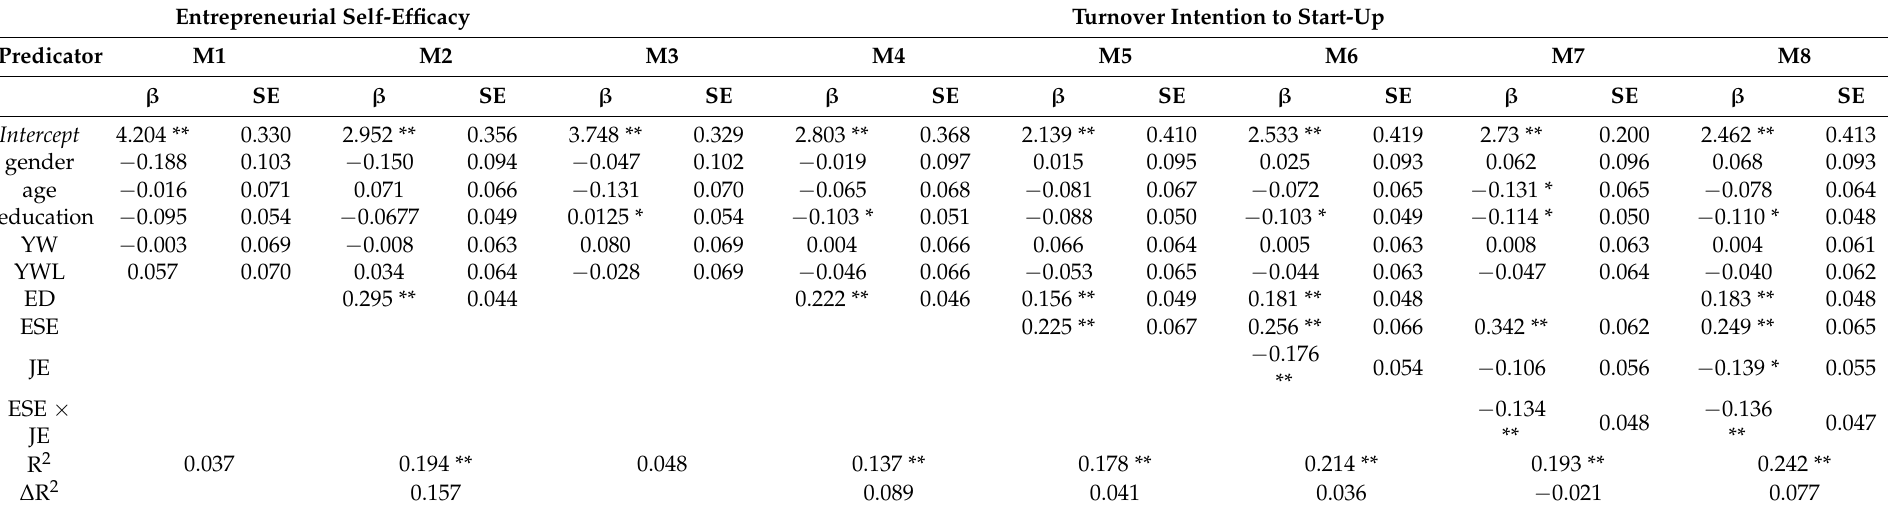
Table 7. Regression analysis